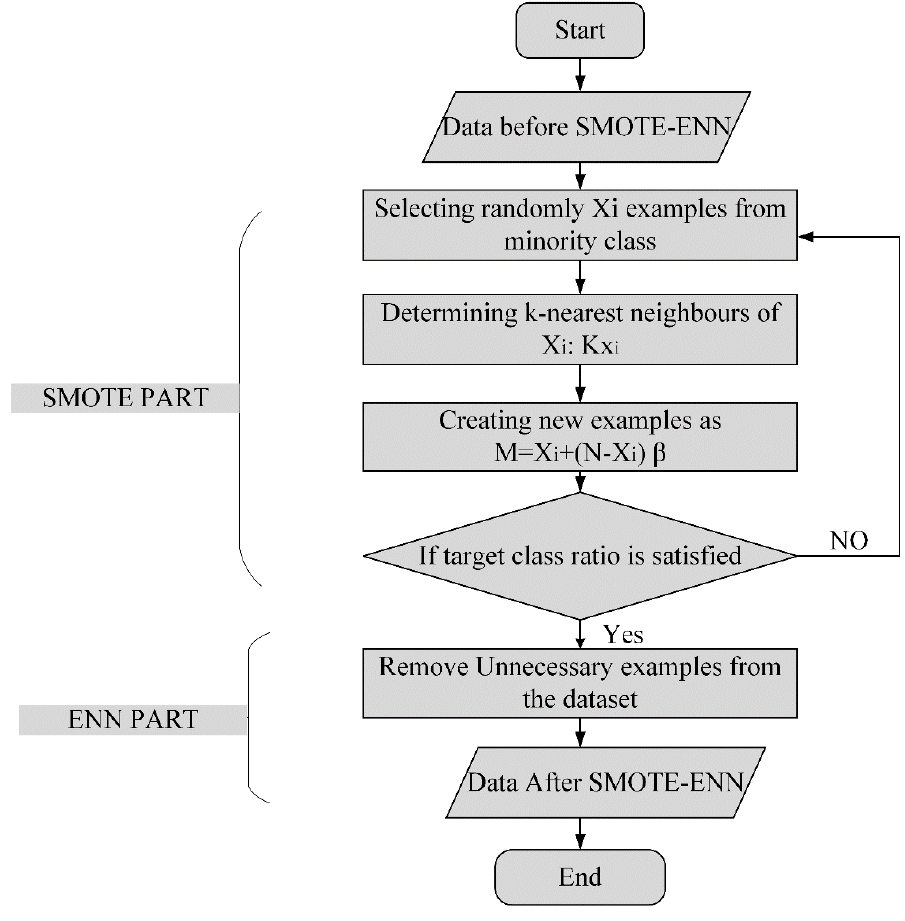
Figure 5. Flow diagram of SMOTE-ENN [39].